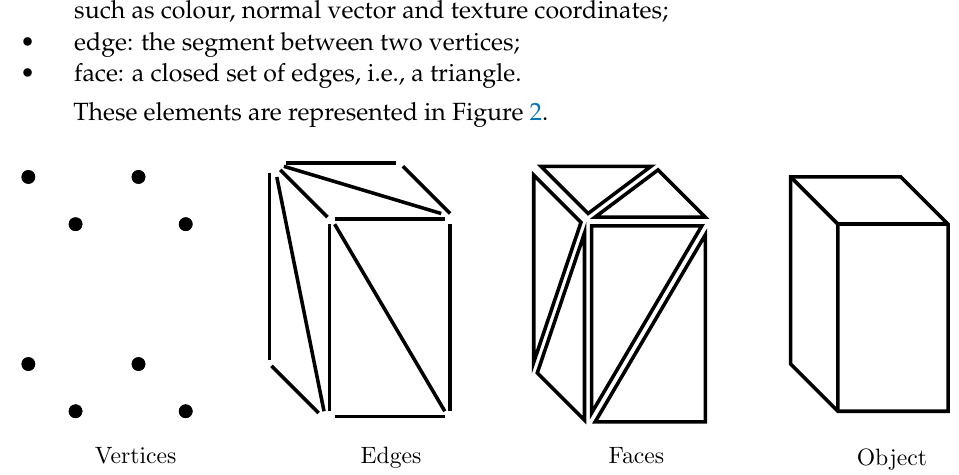
Figure 2. Representation of the core elements of a